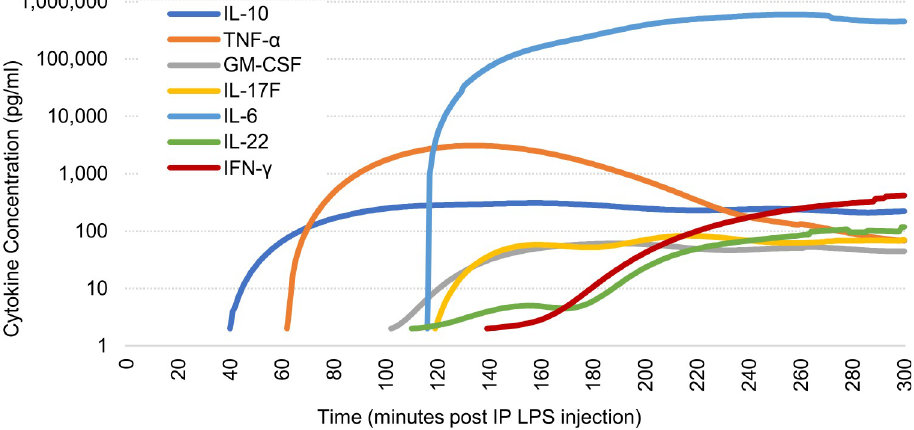
Fig 5. Averaged temporal cytokine profiles of SubD Sham (n = 8) subgroup. Average cytokine cascade due to an IP LPS injection (5 mg/kg) at time t = 0. Logarithmic scale is used to show all elevated cytokines.